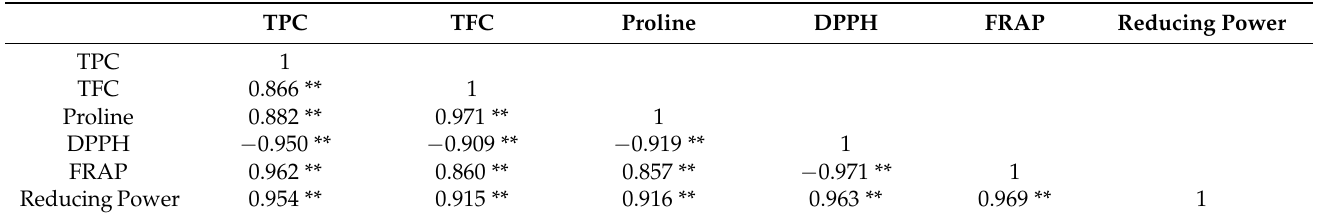
power (r = 0.963). The correlation between FRAP and reducing power was 0.969. These three methods for evaluating the antioxidant capacity of honey have similar results. Table 3. Correlation analysis of antioxidant components and antioxidant activity. TPC TFC FRAP Reducing